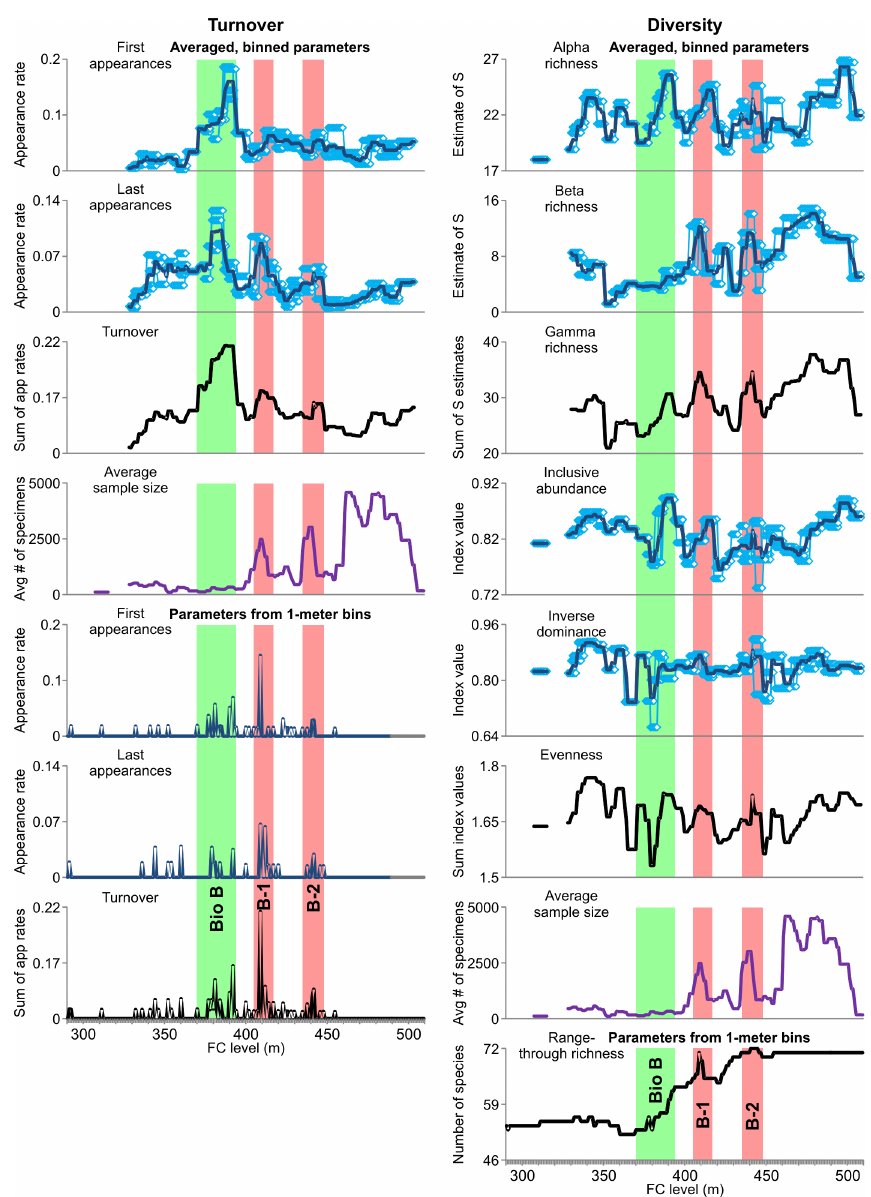
Figure 4. Paleoecological parameters calculated for the FC fossil mammal fauna. The individual turnover, richness and evenness parameters averaged from the optimal 5, 6, 7, and 8m thick binning series (blue lines) and individual bin values (diamonds) are shown along with summative turnover, richness and evenness parameters (black lines). The averaged, binned parameters are compared with the original (prior to standardization) average, binned sample sizes (purple lines) to demonstrate little likelihood of lingering sample size bias. The averaged, binned parameters are also compared with turnover and range-through richness ( S ) parameters (sample size biased) calculated from the data binned by meter level to demonstrate the congruence of parameter